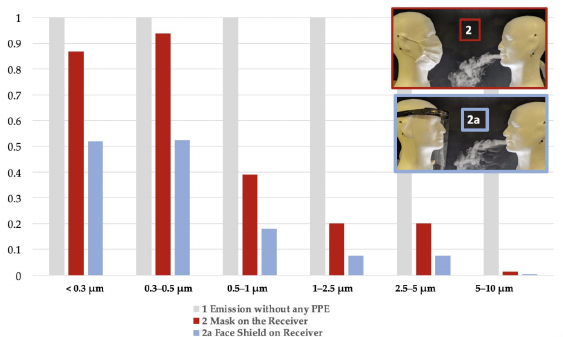
Figure 6. Percentage of Total Inhaled Particles (PTIP) with protection only for Receiver (Re): mask vs. face shield for each particle size range compared to lack of protection.